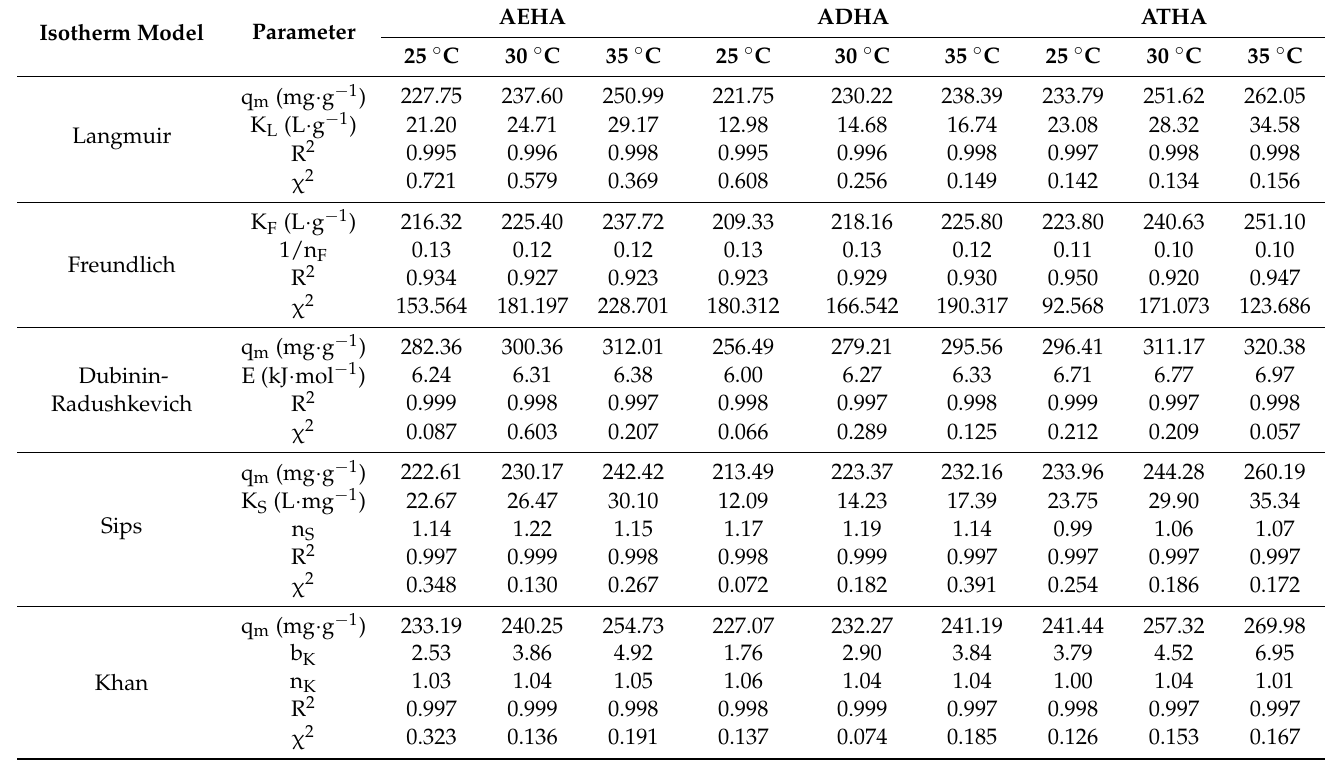
Table 9. Two- and three-parameter isotherm values for adsorption of metronidazole onto AEHA, ADHA and ATHA